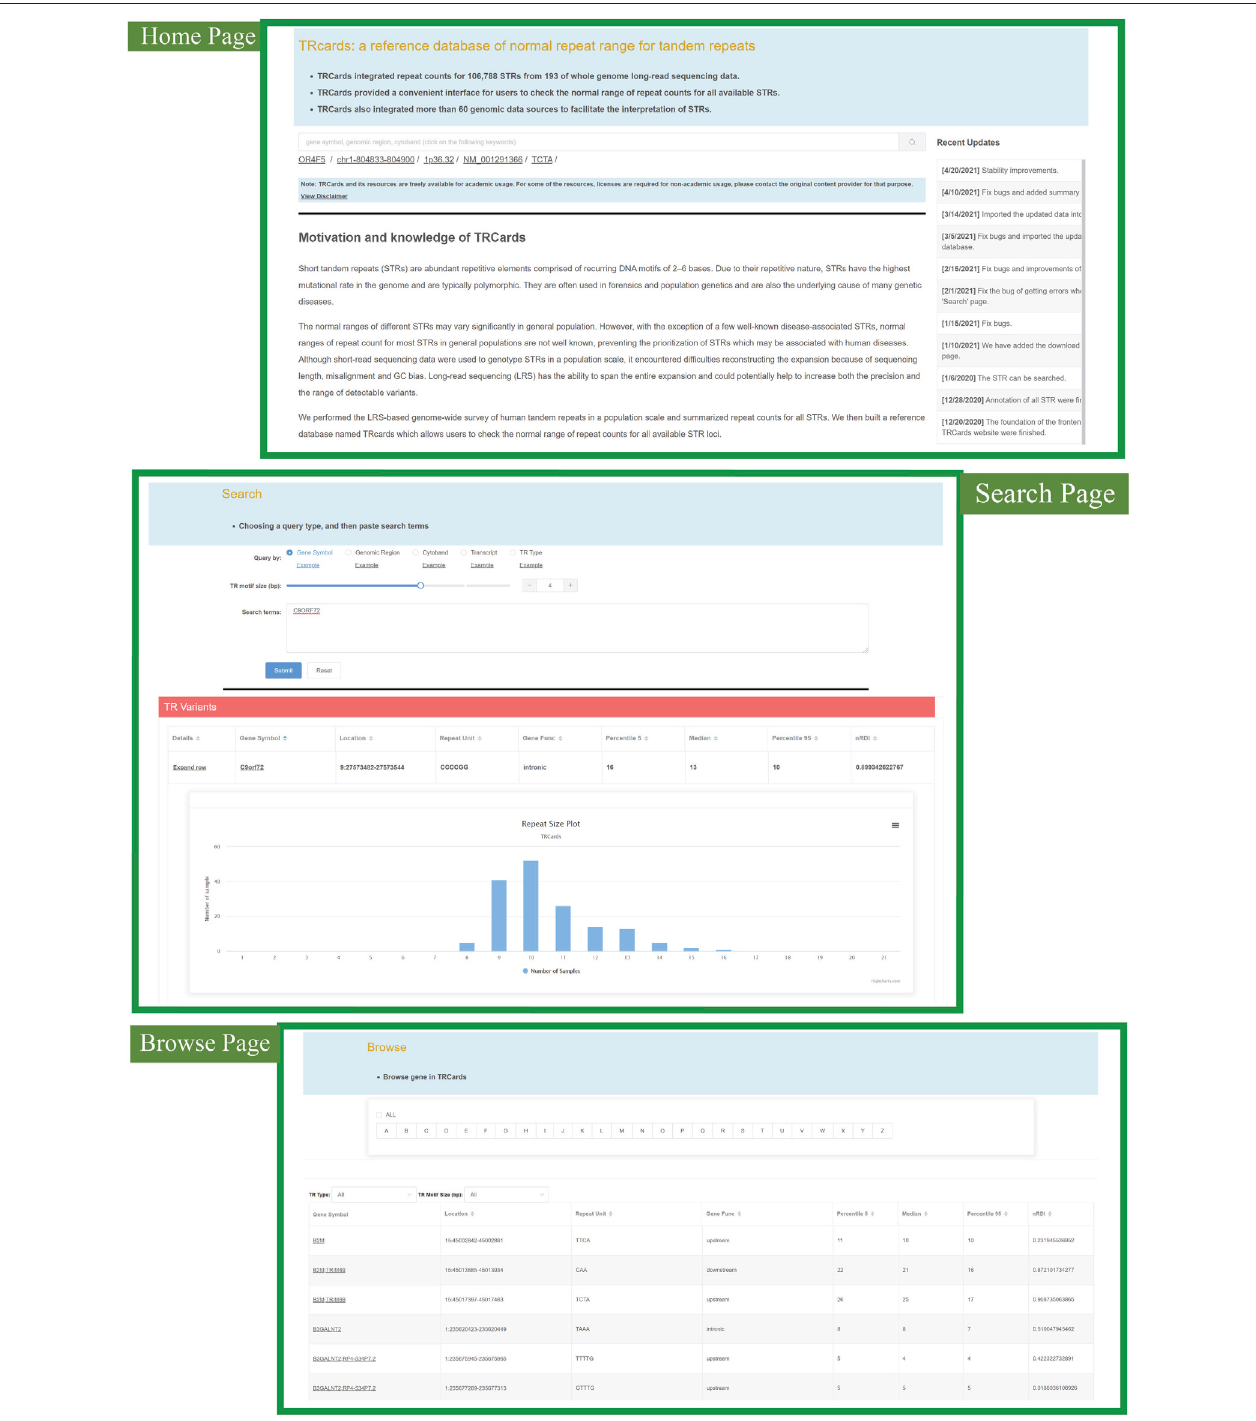
FIGURE 6 | Snapshot of the TRcards web interface (http://www.genemed.tech/trcards/home). “ Home page ” shows the introduction and motivation of TRcards. Thereareapproachestoaccessspeci fi cSTRsinthe “ Searchpage ” and “ Browsepage ” throughdifferentinputquerytypes.CACCCrepeatinFAM41Cgeneisillustrated as an example to show the information for each STR locus, including the chromosome, the starting position of the repeat, the end position of the repeat, the 5 and 95 percentile of the repeat counts, nRDI value, and the plot of repeat size distribution.